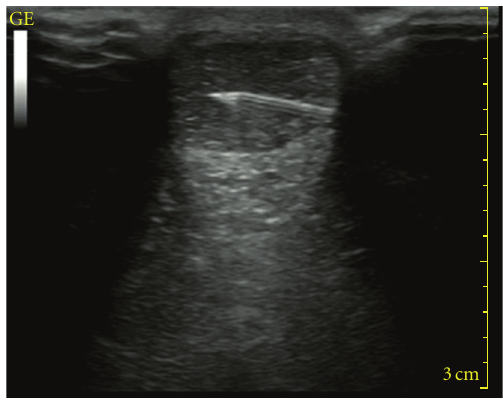
Figure 4: Ultrasonographically guided intratendinous Achilles